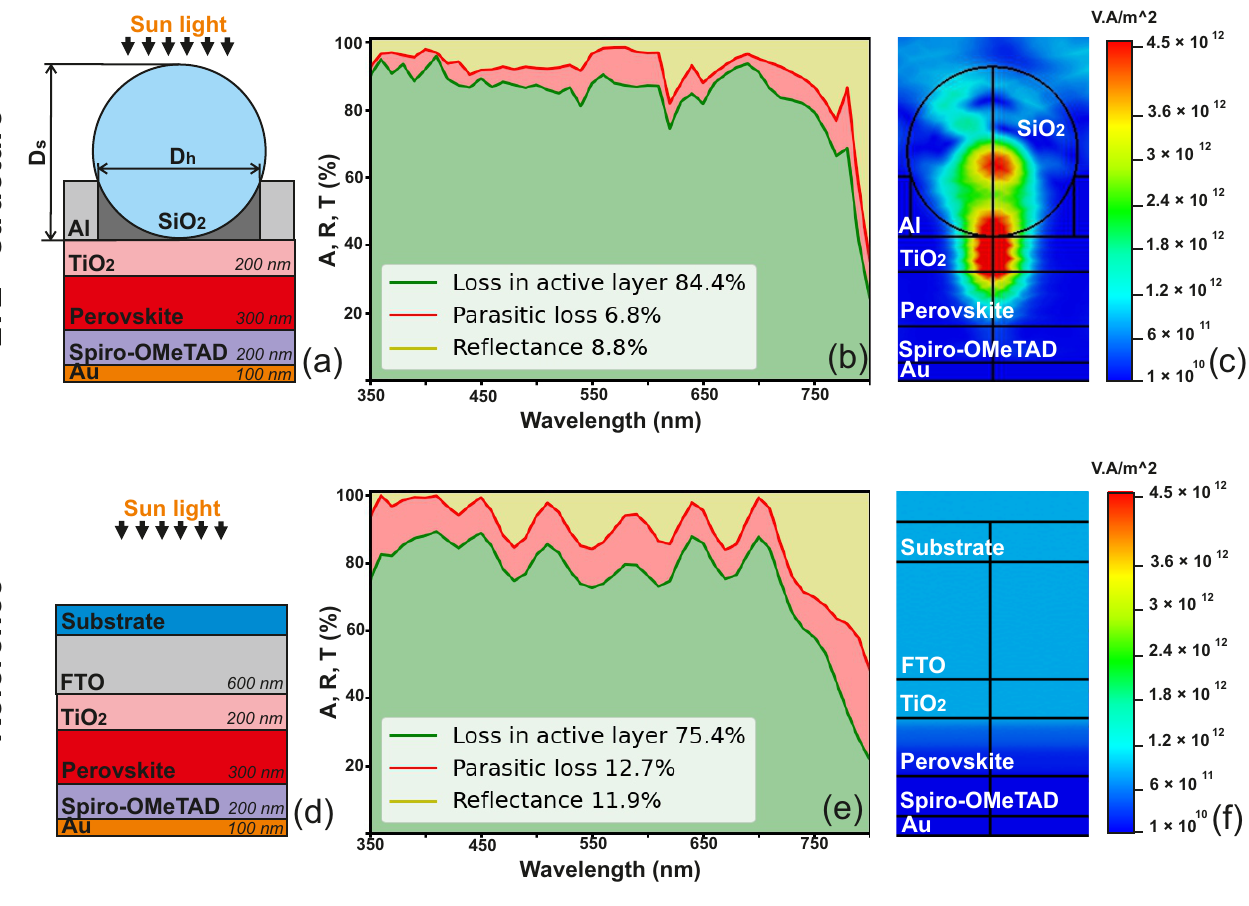
Figure 3. Optical efficiency analysis of monofacial PSCs (calculated for λ = 350–800 nm). ( a ) The scheme of light-trapping structure for monofacial PSC, D h is the diameter of holes ( D h = 900 nm), D s —diameter of spheres ( D s = 940 nm), ( b ) spectral absorption, transmission, and reflection of the light-trapping structure for the monofacial PSC, ( c ) power flow of the light-trapping structure for the monofacial PSC at a wavelength of 650 nm with a nanosphere size 940 nm (TE—polarization), ( d ) scheme of the reference monofacial PSC, ( e ) spectral absorption, transmission, and reflection